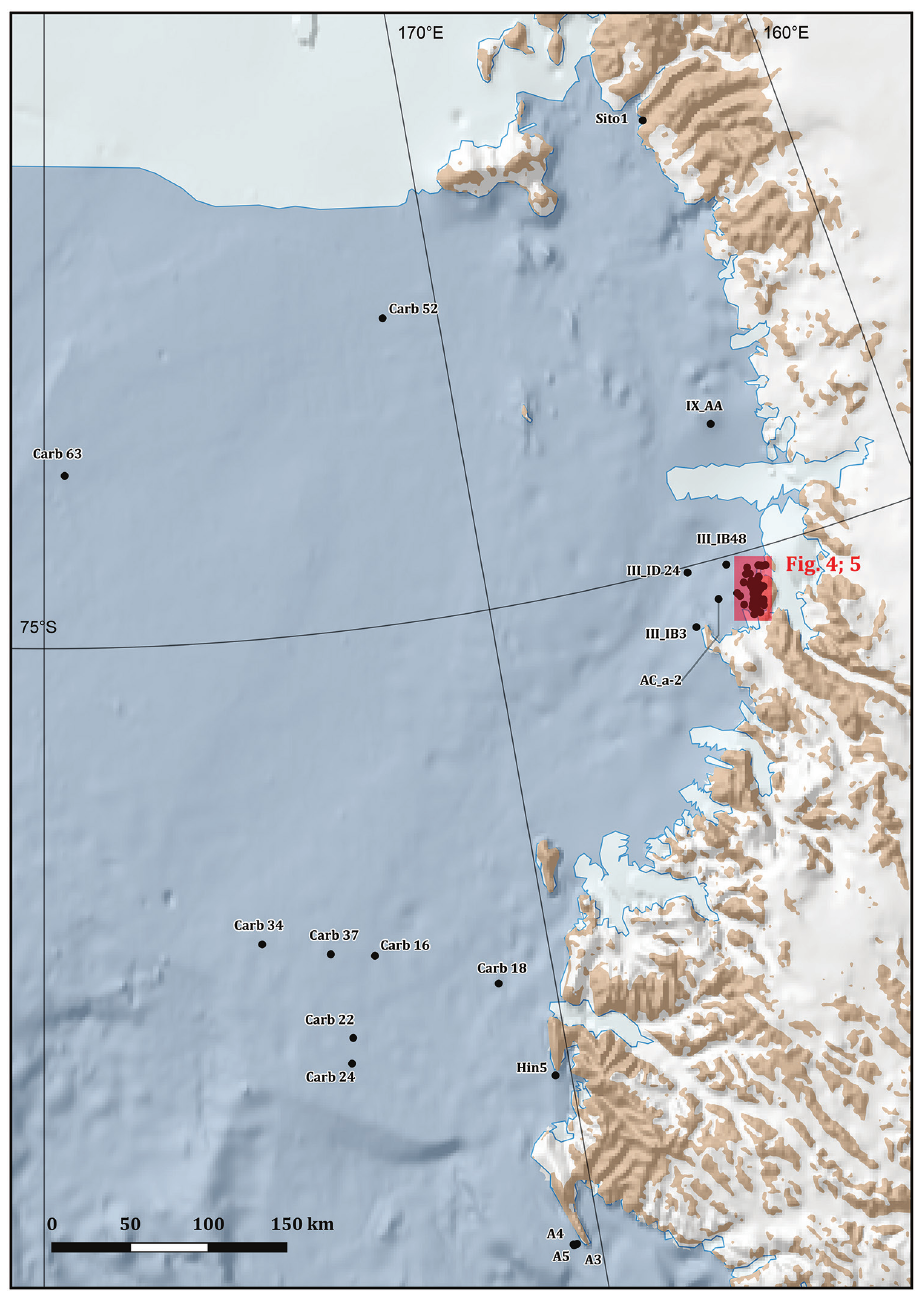
Figure 3. Sampling stations map in the Ross Sea area, Antarctica. The area in the red box is depicted, at a finer spatial scale, in Figs 3,